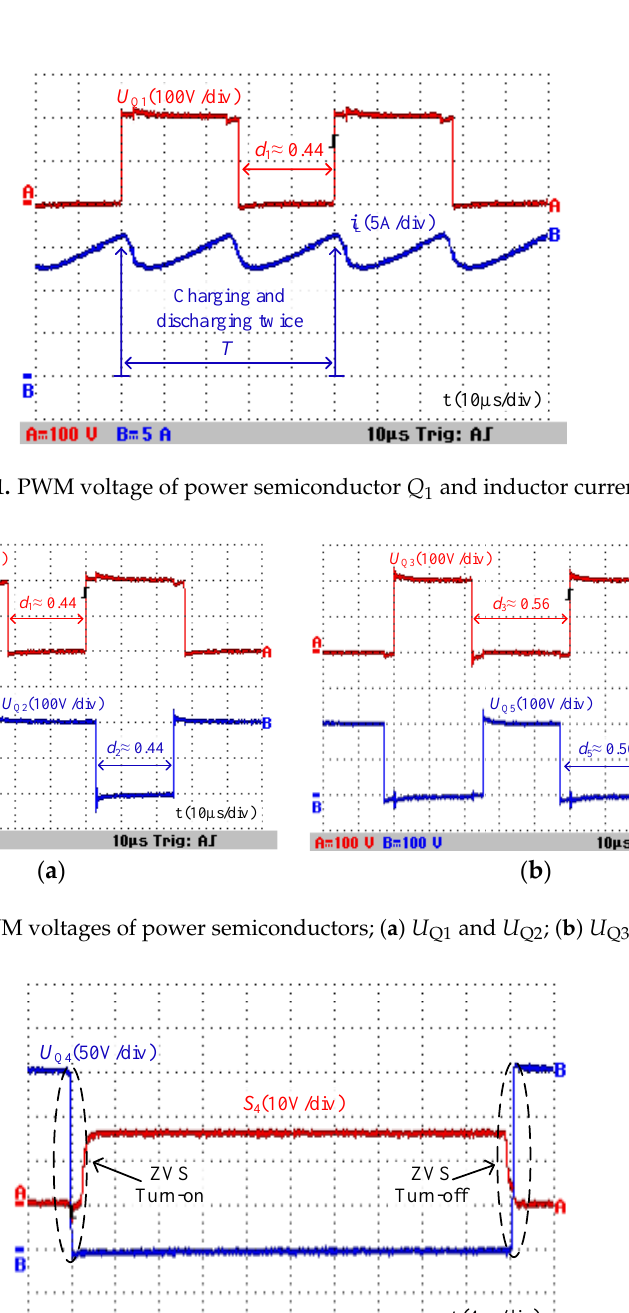
Figure 13. Voltage stress and gate signal of synchronous rectification power switch Q 4 .